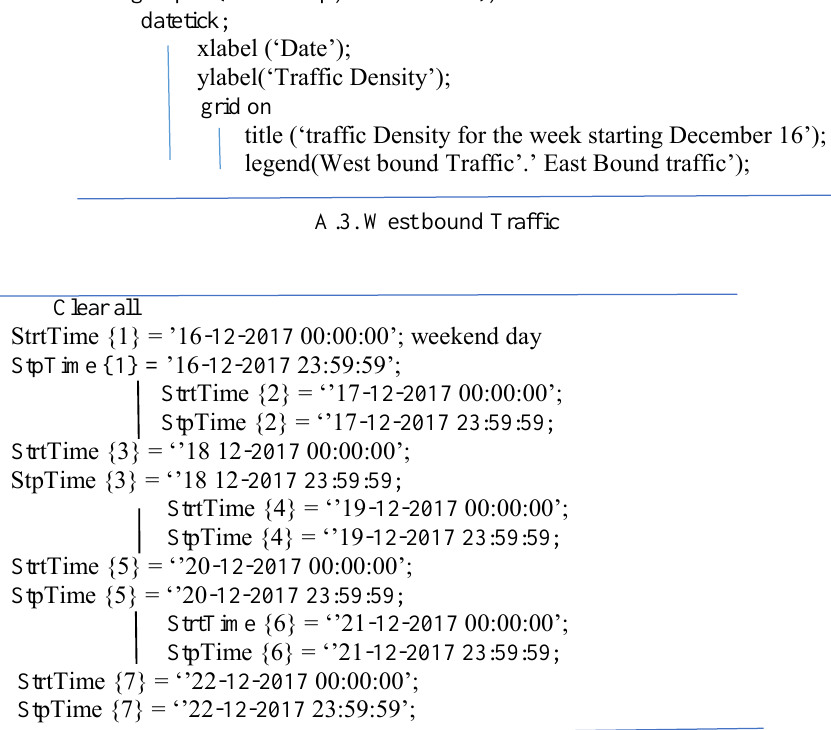
figureplot( timestamp,